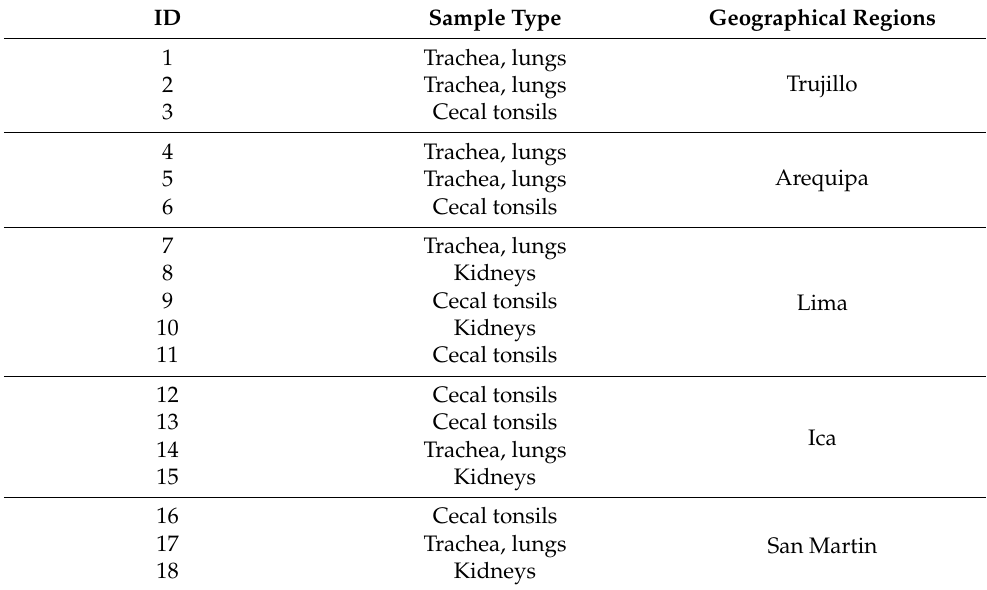
Table 2. Sample information for S1